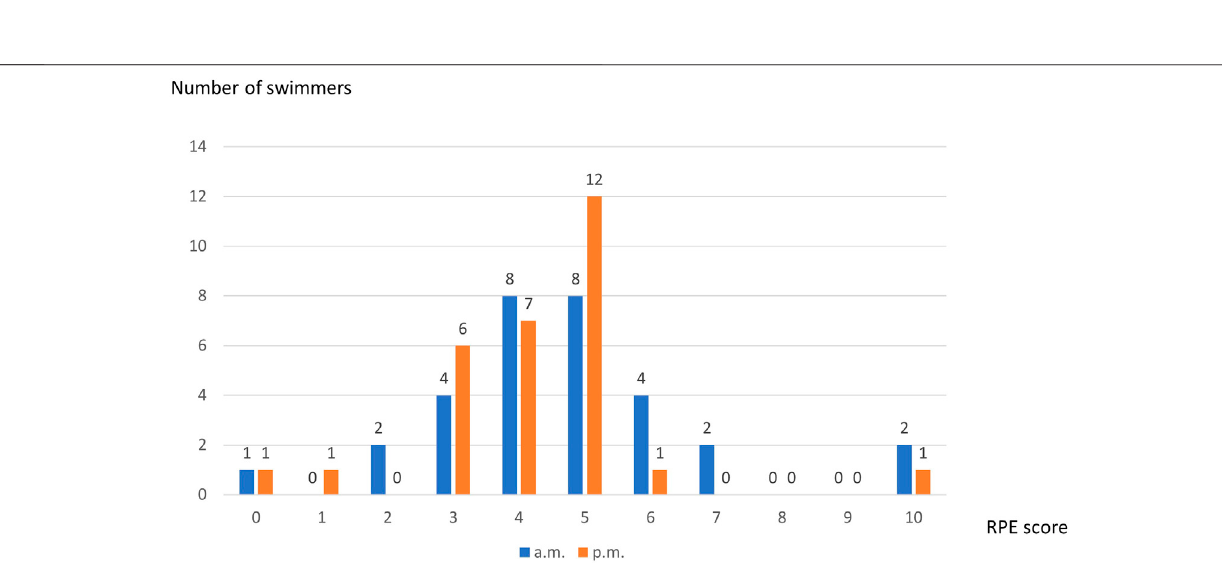
Frontiers in Physiology |